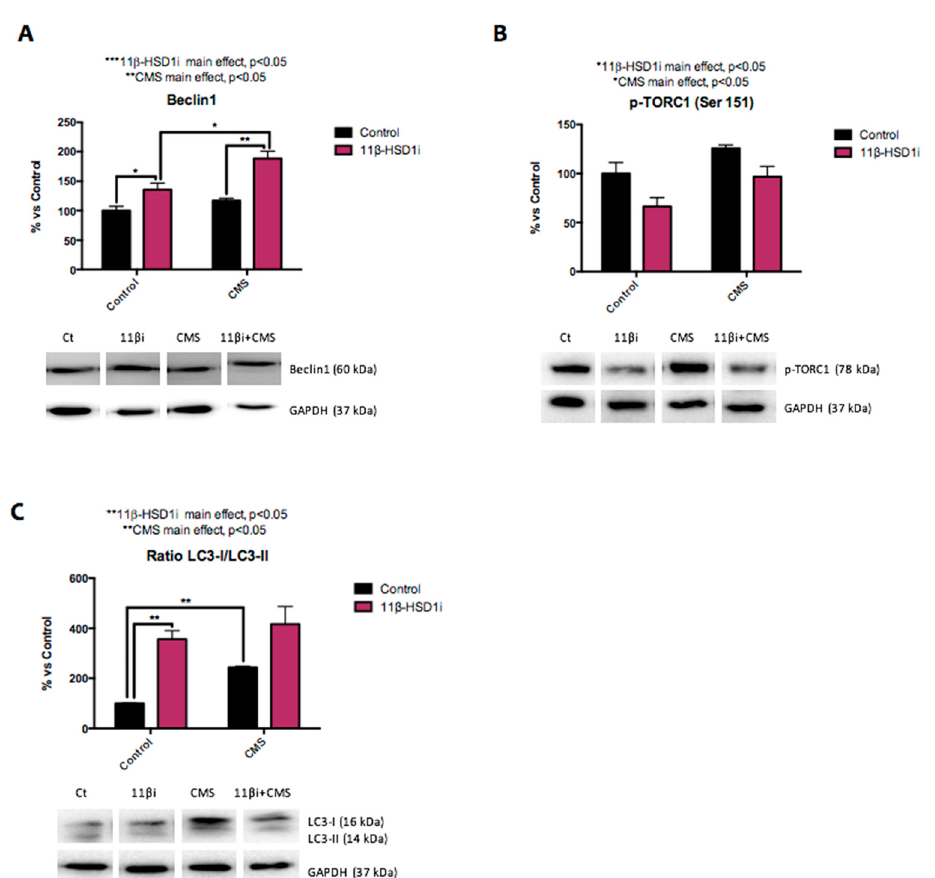
Figure 5. Representative results from the evaluation of the autophagy process. Representative Western blot for Beclin1 protein levels and quantification ( A ), p-TORC1 (Ser 151) protein levels and quantification ( B ), and the ratio of LC3 protein levels and quantification ( C ). Values in bar graphs are adjusted to 100% for protein levels of SAMP8 Control (Control). Values are mean ± standard error of the mean (SEM) ( n = 4 for each group). 11 β -HSD1 and CMS main effects as well as interactions were determined. * p < 0.05; ** p <